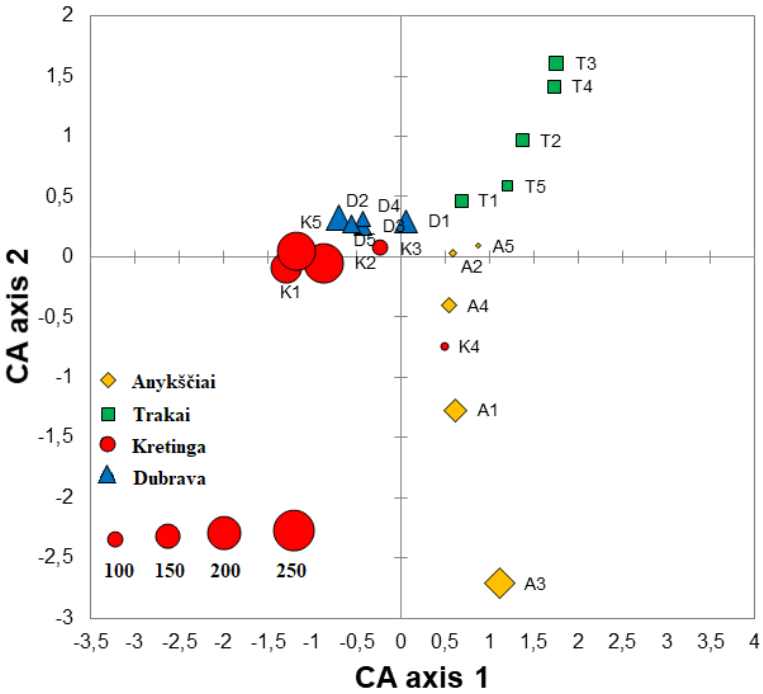
Figure 3. Ordination diagram based on the correspondence analysis (CA) of fungal and oomycete communities in water filtrate samples from four forest nurseries: Anykš č iai, Dubrava, Kretinga and Trakai. Each point in the diagram represents a single sample, and the size of each point reflects the richness of fungal taxa as shown in the lower left